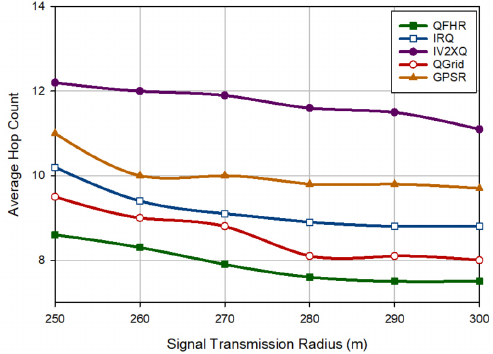
Figure 15. Average number of hops in different approaches with regard to